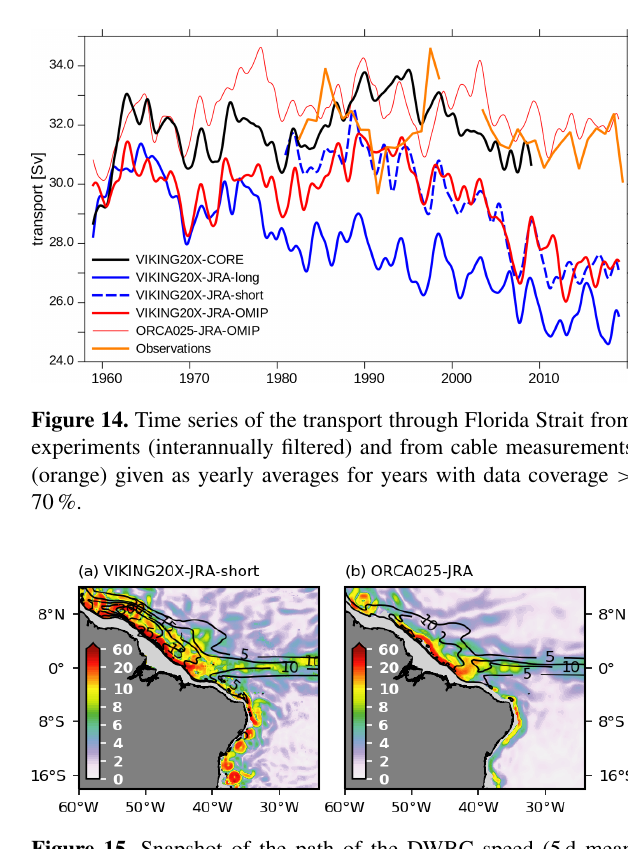
Figure 15. Snapshot of the path of the DWBC speed (5d mean centred around 22 February 1990, density range as in Fig. 7) and upper-ocean eddy kinetic energy (contours, in Jm − 3 , mean between 1990–2009 for the upper 1000m) for (a) VIKING20X-JRA-short and (b)